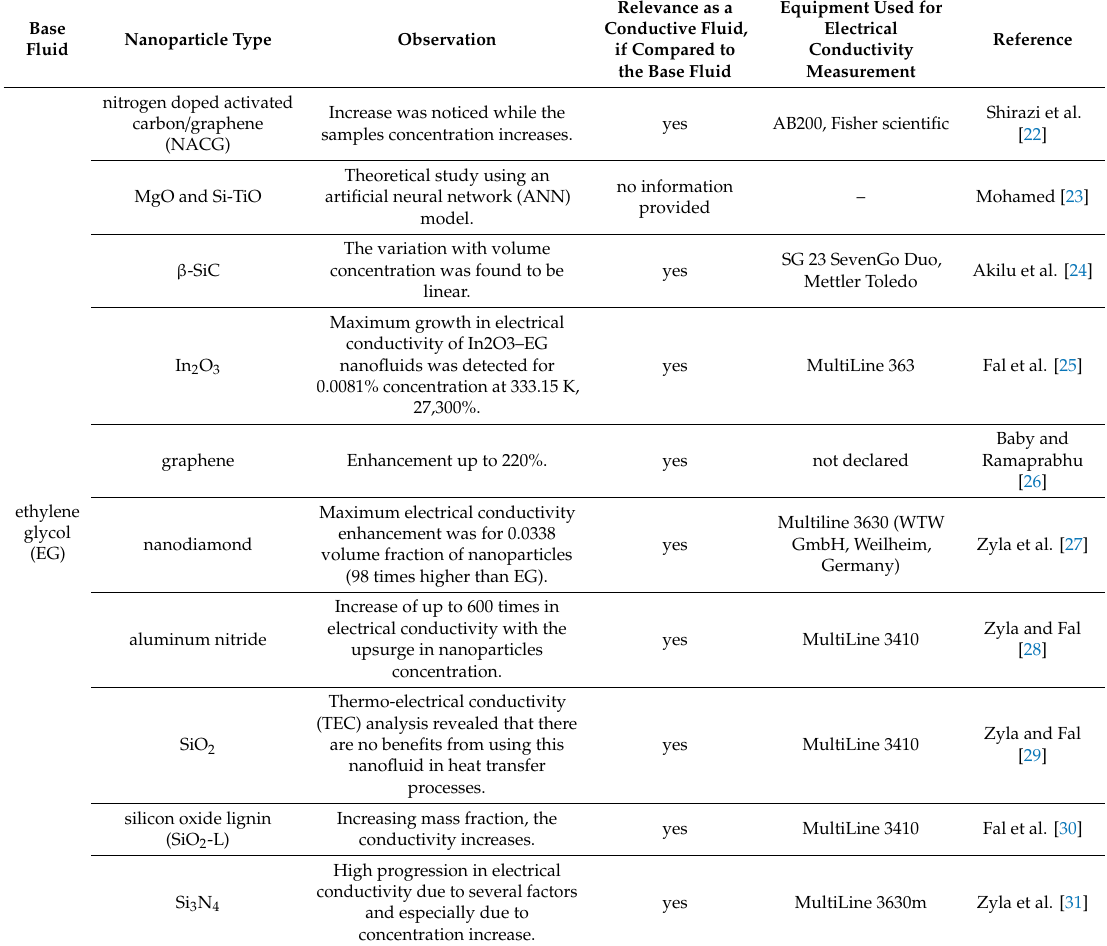
Table 1. Outline of experimental work on electrical conductivity of